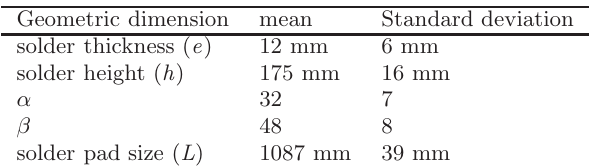
Fig. 3. Dimension characterising the solder bump. Table 1. Geometric dimension results of cross section of bump connection according to Figure